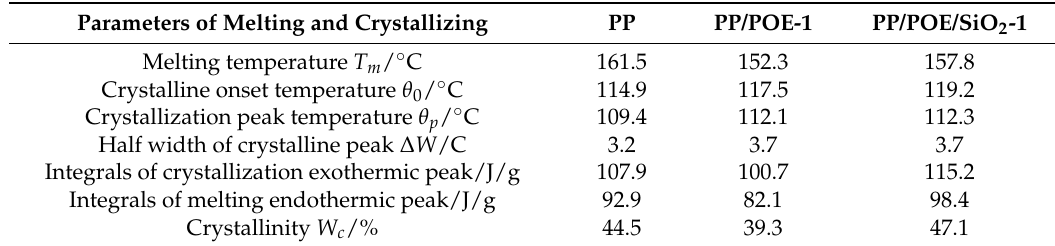
Figure 5. Heating and cooling curves of DSC. Table 3. Parameters of isothermal crystallization and the melting process.